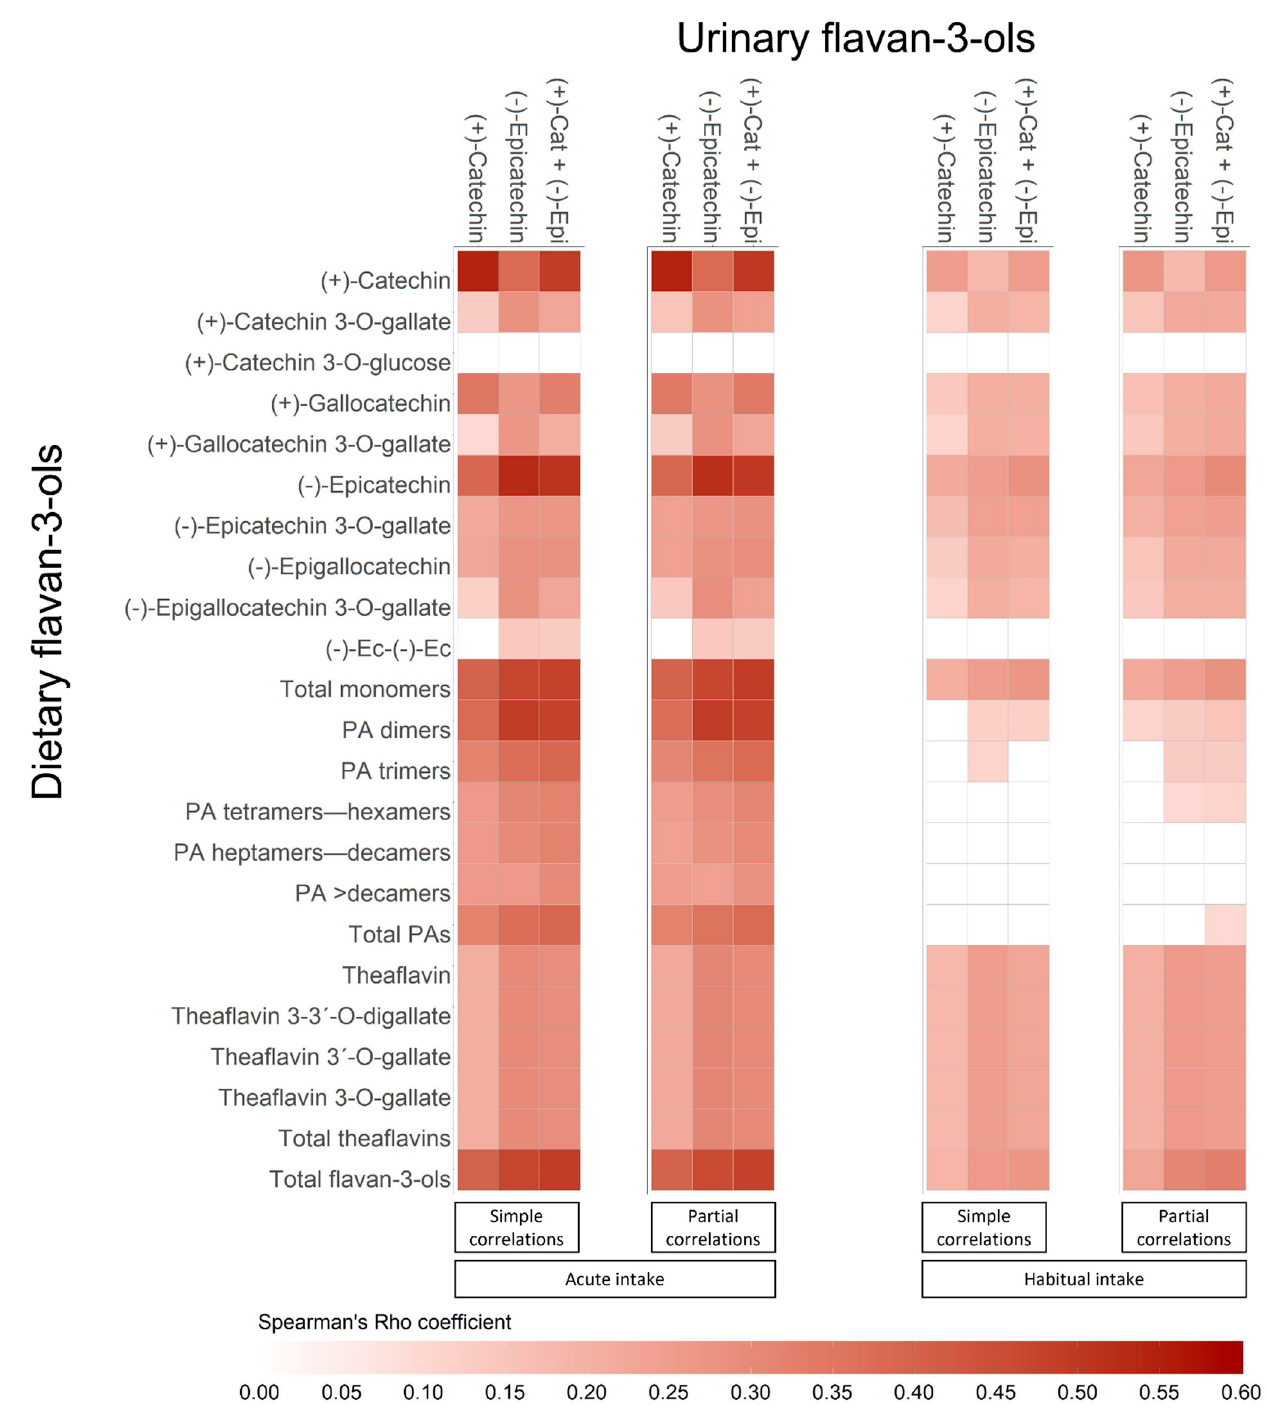
Figure 1. Heatmaps showing simple and partial Spearman’s correlations between urinary and dietary intake (acute and habitual) of flavan-3-ols. Abbreviations: 24-HDR, 24-h dietary recall; (+)-Cat, catechin; DQ, dietary questionnaire; Ec-Ec, (-)-epicatechin-(2a-7)(4a-8)-epicatechin 3-O-galactoside; (-)-Epi, (-)-epicatechin; PA,